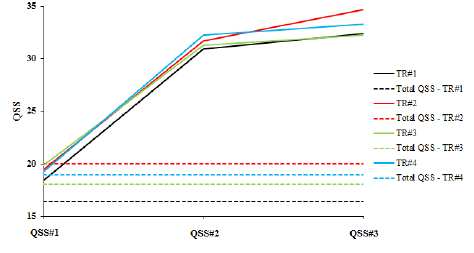
Figure 5. Evolution of QSS over each TR for HMPE#2.